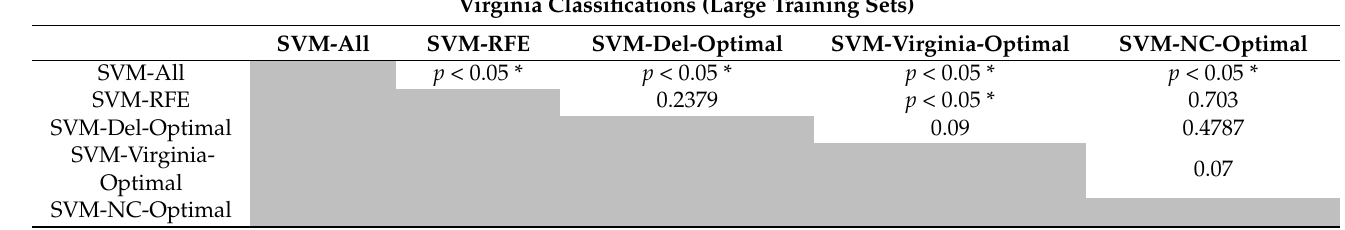
Table A5. Paired t -test p -values for Virginia classifications trained from the large training sets. (* Indi- cates at a 95% confidence that the differences in mean classification accuracies between classification groups are statistically significant, p < 0.05).